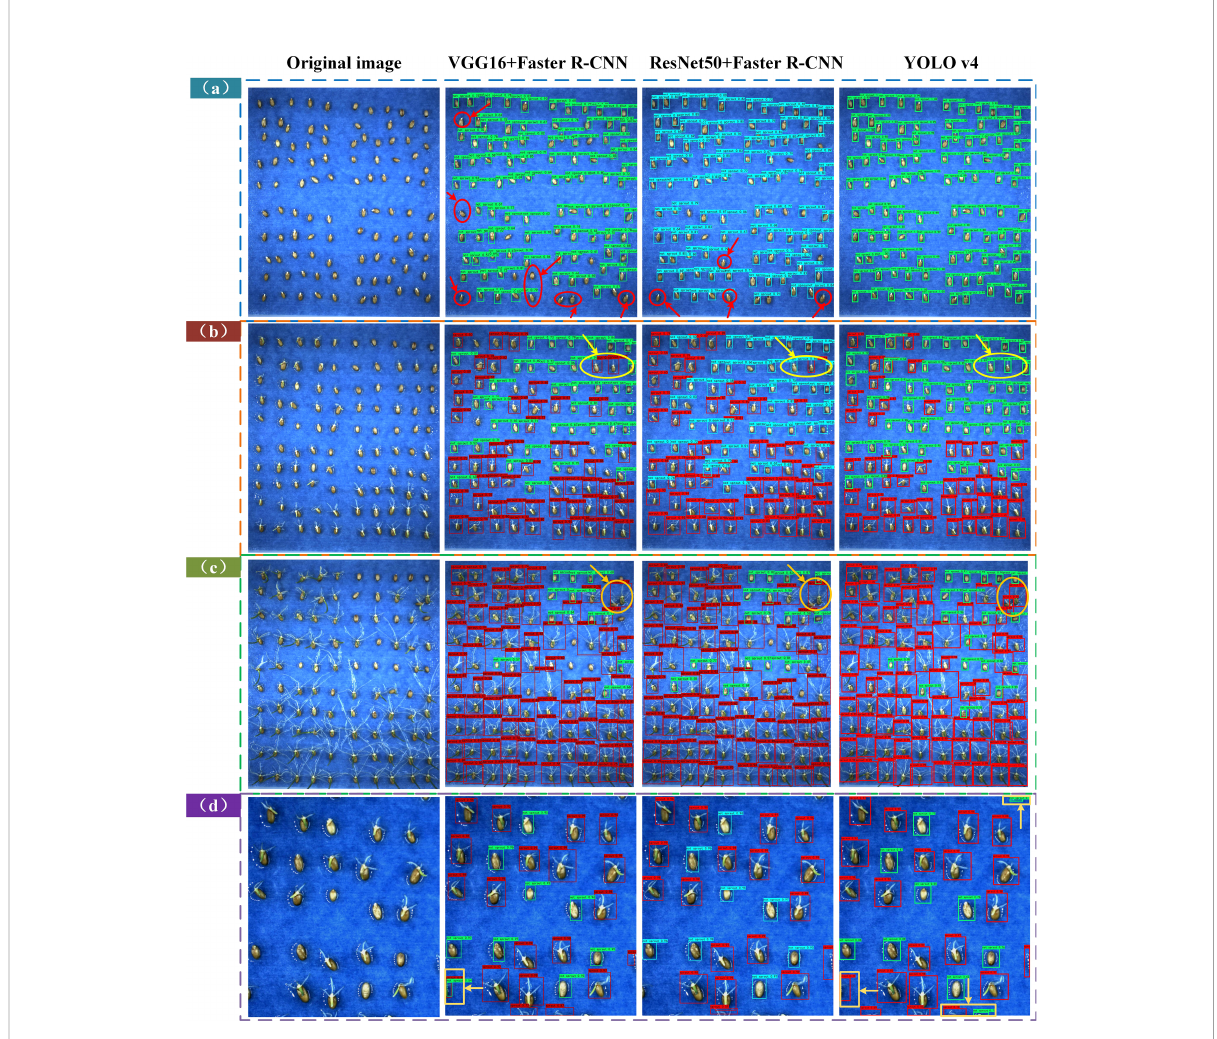
FIGURE 7 Comparison of the detection effect plots of the three models on the four test sets. (A) Test set test01 (B) Test set test02 (C) Test set test03 (D) Test set